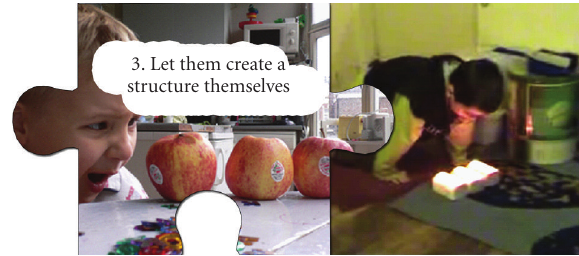
Figure 7: Organising: (a) Beer loves to make sequences of objects; here you see Beer making a sequence with apples. (b) Robbert playing with LINKX; he loves to make blocks into the same colour and arrange them in